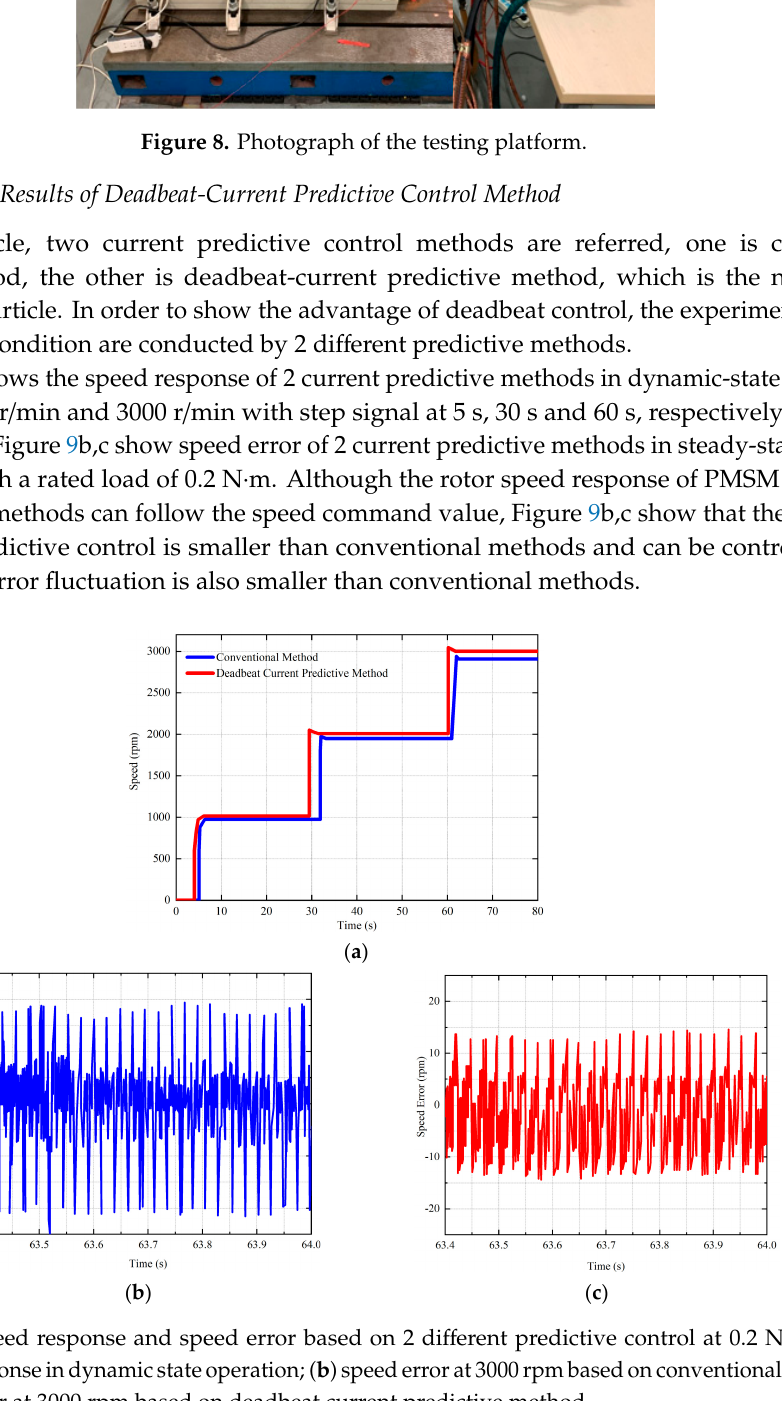
Figure 9. Speed response and speed error based on 2 different predictive control at 0.2 N · m Speed response in dynamic state operation; ( b ) speed error at 3000 rpm based on conventional method; ( c ) speed error at 3000 rpm based on deadbeat current predictive method.